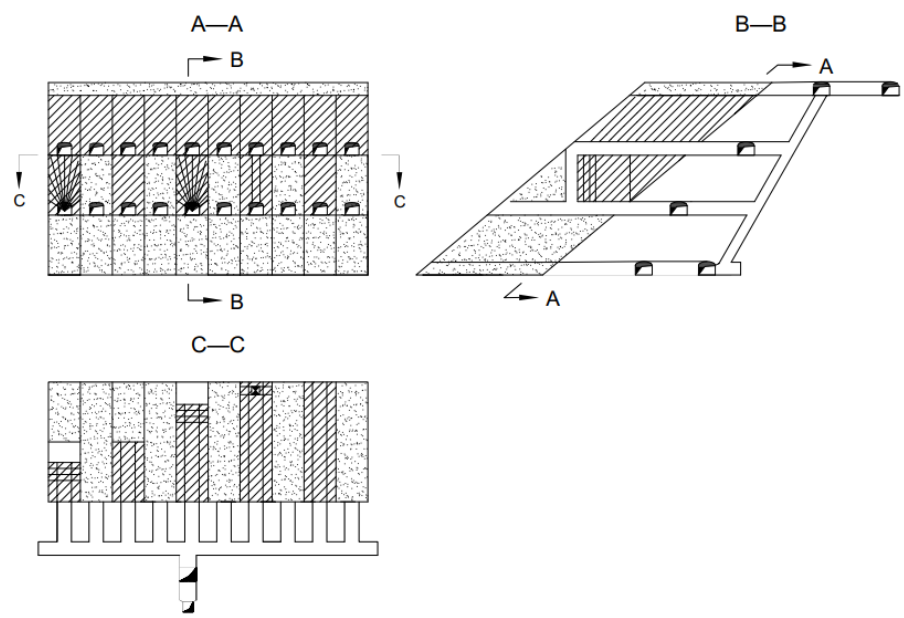
Figure 7. Three-dimensional model of ore body. ( a ) Overall three-dimensional model of ore body; ( b ) Three dimensional model of −915m ~ −960m middle section ore body.